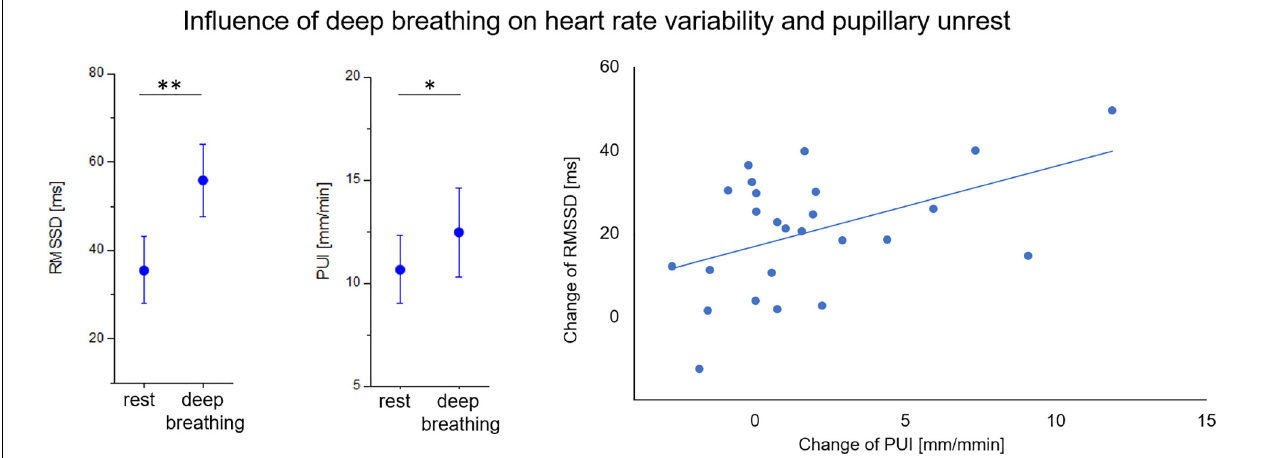
FIGURE 3 | Effect of deep breathing on short-term heart rate variability (RMSSD) and pupillary unrest index (PUI). Increases of both parameters during breathing test were correlated ( r = 0.47, p < 0.01). ∗ p < 0.05, ∗∗ p < 0.01.